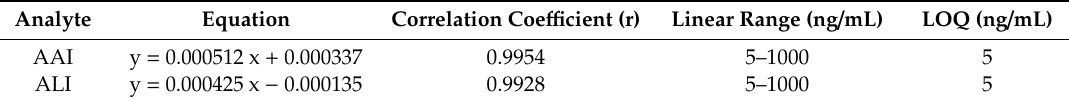
Table 3. Linearity, limit of quantitation (LOQ) of the LC-MS / MS assay for AAI and ALI in serum. Analyte